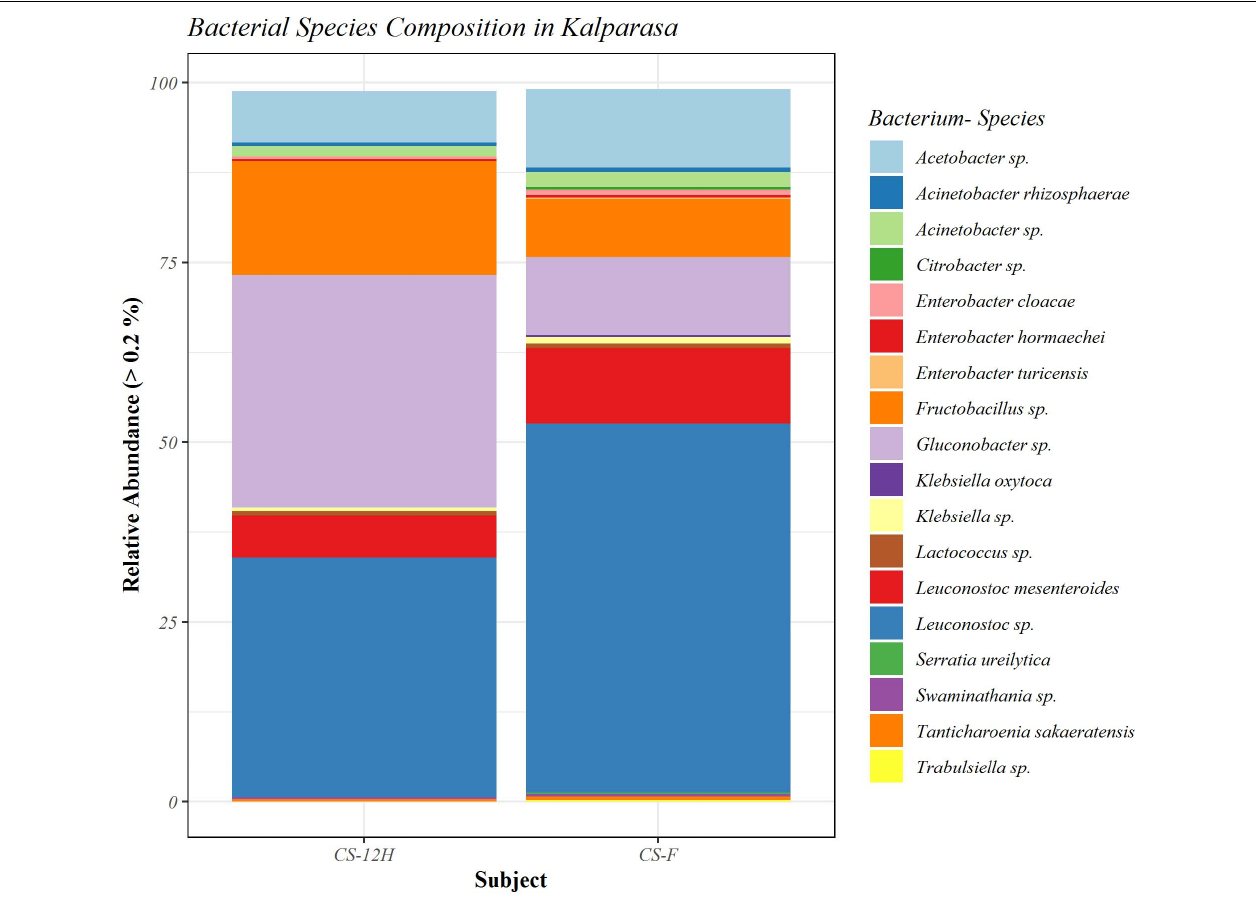
FIGURE 1 | Bar plot representing relative abundance percentage ( > 0.2%) of detected bacterial species in fresh (CS-F) and fermented (CS-12H) Kalparasa